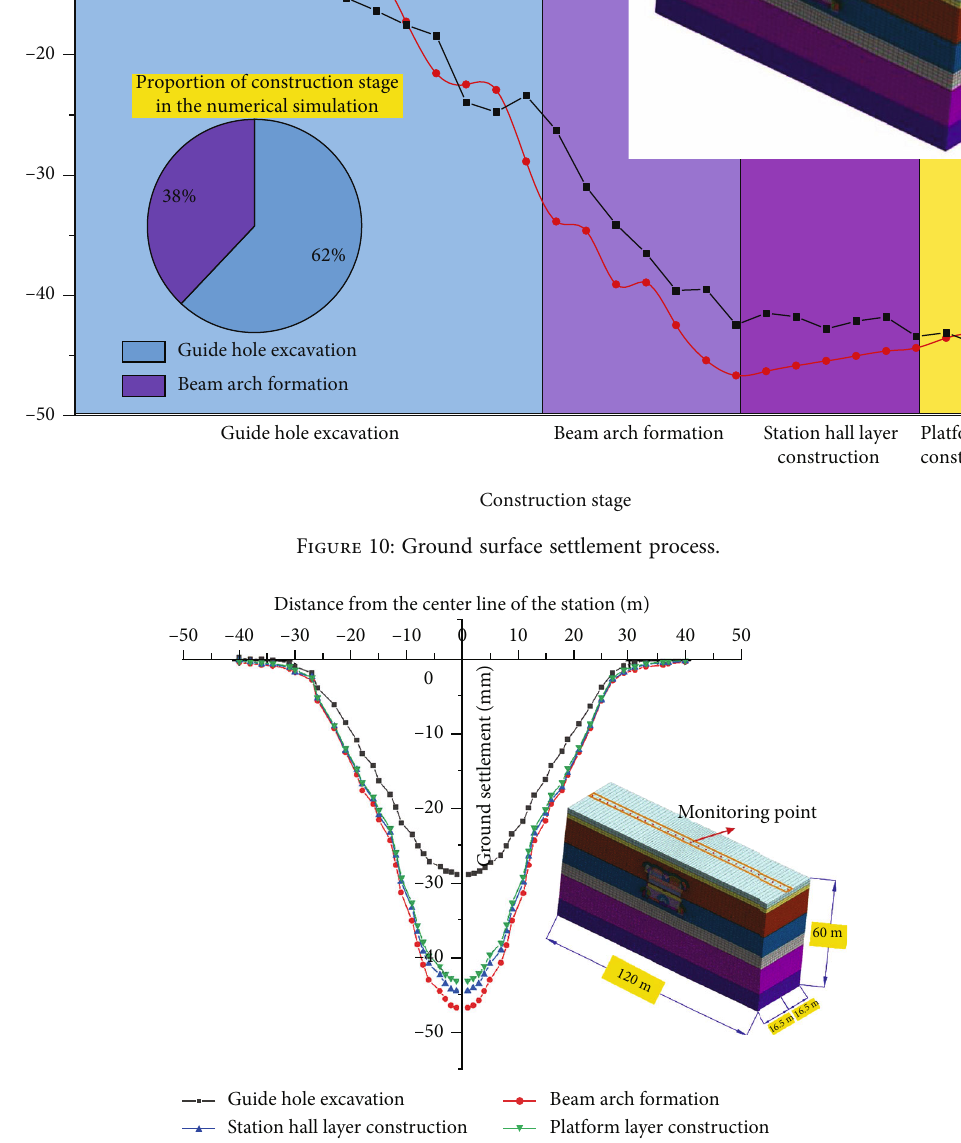
Figure 11: Ground surface settlement